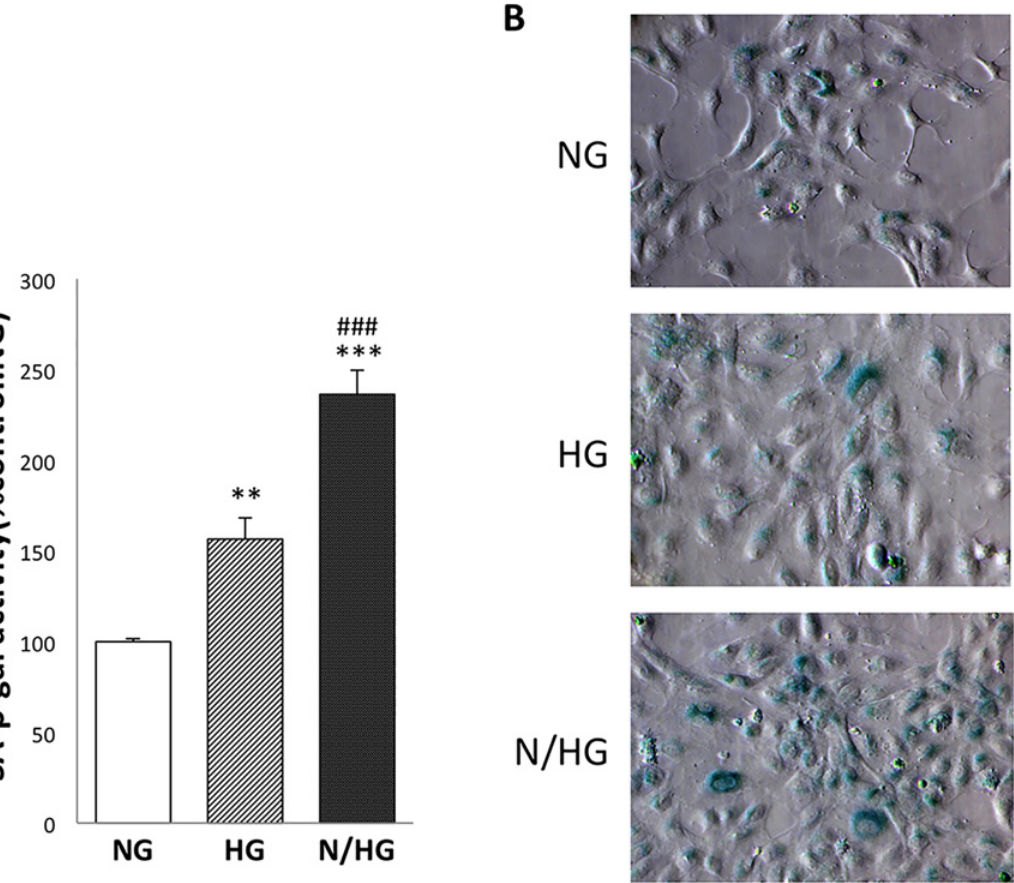
Fig 2. Effect of high glucose on SA- β -gal activity in HUVECs. NG, constant normal glucose (5 mM); HG, constant high glucose (22 mM); and N/HG, 5 mM alternating with 22 mM glucose. To confirm the effect of glucose in HUVECs, NG, HG and N/HG were cultured with each Stimulus for 3 days. HUVECs were cultured with constant high glucose (HG) and intermittent glucose (N/HG) introduced in Fig 1. Namely, N/HG was stimulated twice with HG (at 4-hour intervals) for a total of 4 hours daily (9 a.m. to 11 a.m., 3 p.m. to 5 p.m.), and was cultured in NG in other time of the total 4-hour HG stimulation. (A) SA- β -gal activity was evaluated cytochemically. The values of the three independent experiments are mean ± S.D. ** p < 0.01; *** p < 0.001 vs. NG; ###p < 0.001 vs. HG. (B) SA- β -gal-positive cells (blue) can be detected via cytochemical staining.